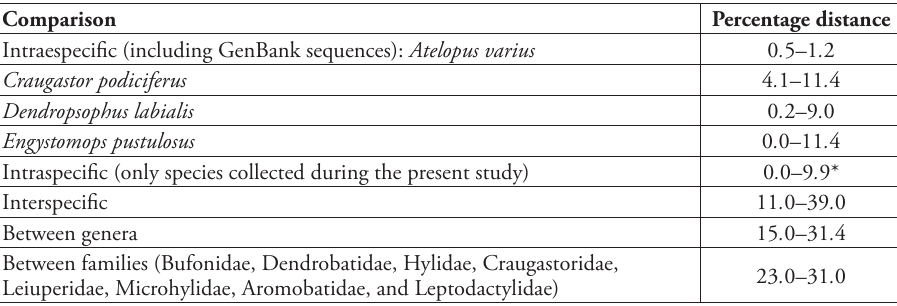
Table 1. Range of intraspecific and between-taxon divergence values recorded in the present study